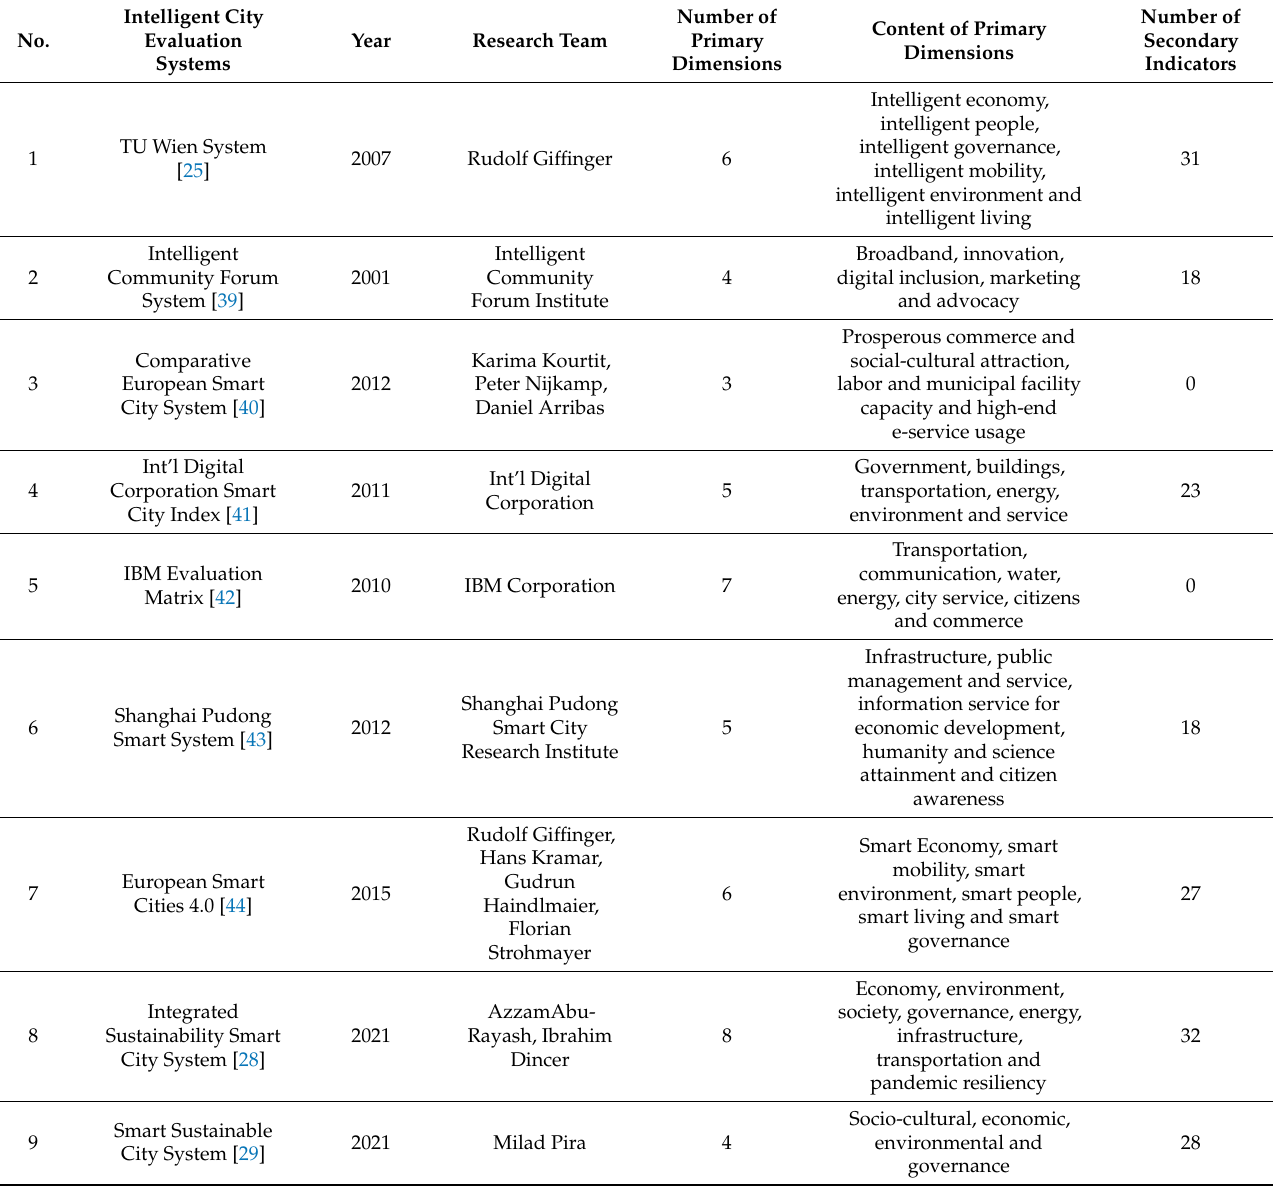
Table 1. Some of the existing major intelligent city evaluation